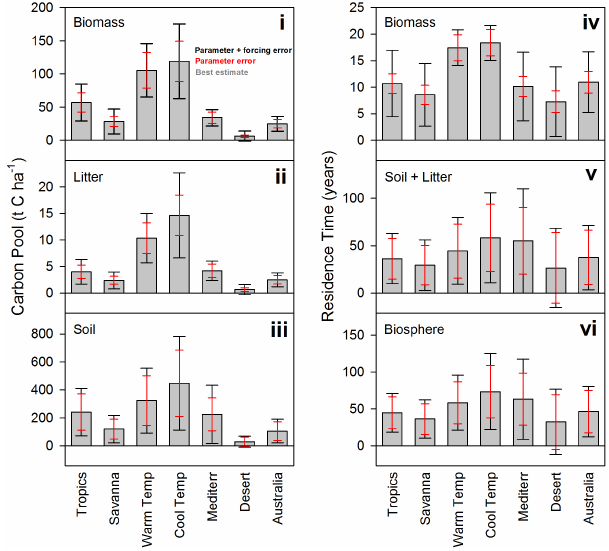
Fig. 15. Carbon pools and turnover times by bioclimatic classifica-